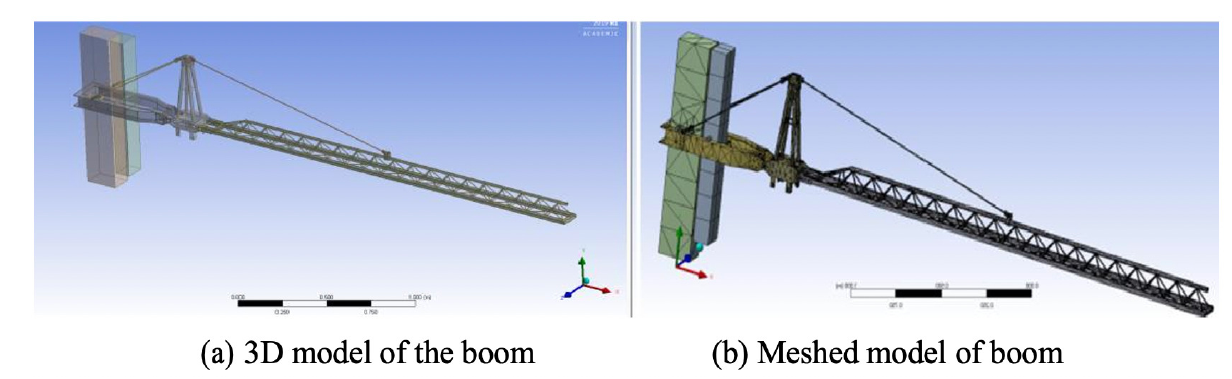
Figure 5. 3D model of the boom and its mesh model in Ansys Workbench